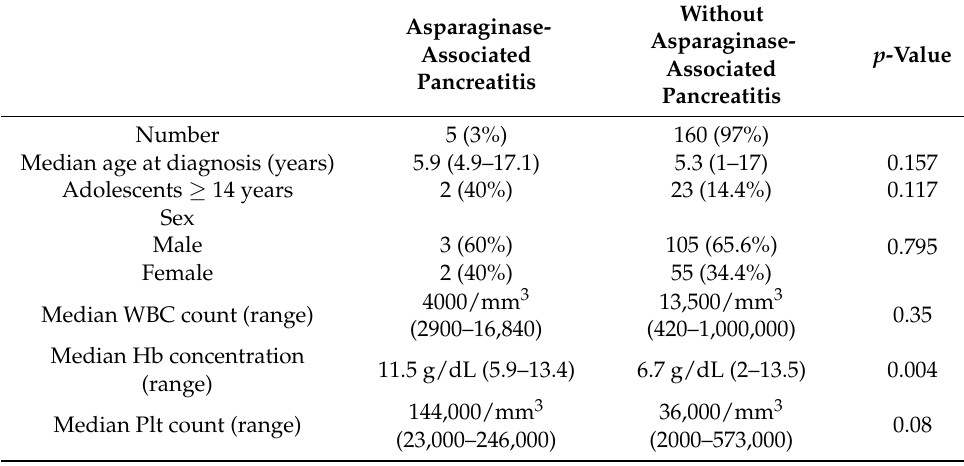
Table 7. Biological features and outcomes of patients with and without